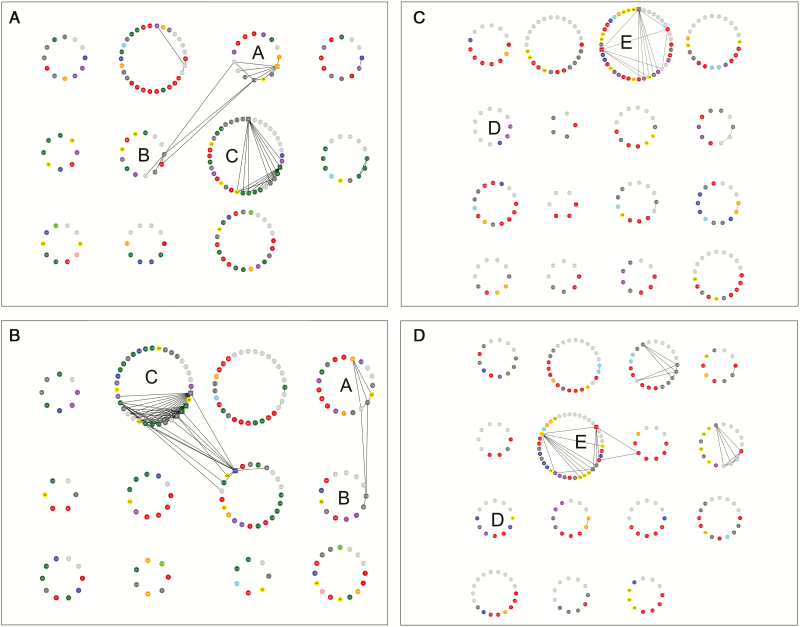
Correlation networks constructed for proteins observed in leaves in control (A) and drought conditions (B) and roots in control (C) and drought conditions (D). Proteins are represented by circles with numbers. Circle colors correspond to groups of proteins with different functions (for legend see Fig. 6). Edges link correlated proteins. Correlation matrix was transformed to the TOM, and only edges corresponding to elements of TOM greater than 0.15 are drawn. Squares represent ‘hubs’, i.e. proteins with the largest numbers of edges. Proteins are grouped into modules, i.e. groups of mostly correlated proteins, found by clustering based on the TOM and the dynamic tree cut algorithm. The modules with a large number of proteins (>60%) occurring in both control and drought are marked with letters (A)–(E).